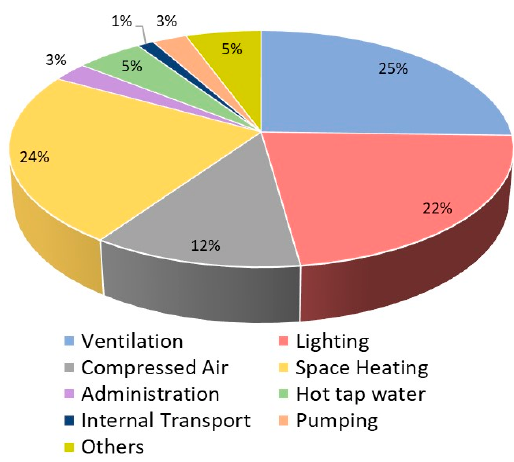
Figure 15. The share of CO 2 emissions for support unit processes in the Swedish engineering industry (Scenario 2).